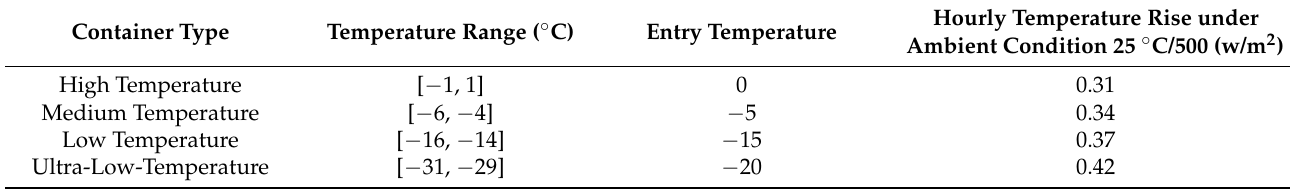
Table 1. Types of Containers.